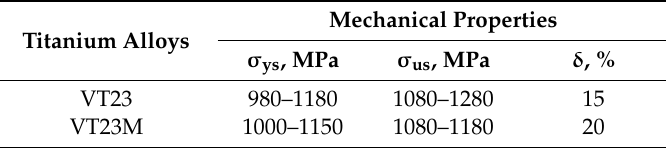
Table 1. Mechanical properties of titanium alloys VT23 and